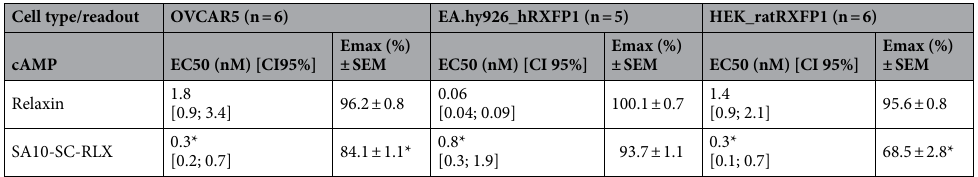
Table 1. Potency and efficacy of SA10SC-RLX in head-to-head comparison with relaxin in different cell types with endogenous or recombinant expression of human or rat RXFP1. Relative EC50s (EC50rel) and Emax were determined with SAS procedure via Biost@t-SPEED-LTS v2.4 internal software using the 4-parameter logistic model. The geometric means of the EC50rel values were calculated with confidence intervals (CI) at 95% level. For Emax comparison between relaxin and SA10SC-RLX, normality hypothesis was confirmed for each group and a paired T test was performed. In the absence of normality hypothesis, a Wilcoxon test was performed. For the EC50 comparison, the same method was applied after log transformation of the value (* P < 0.05 vs